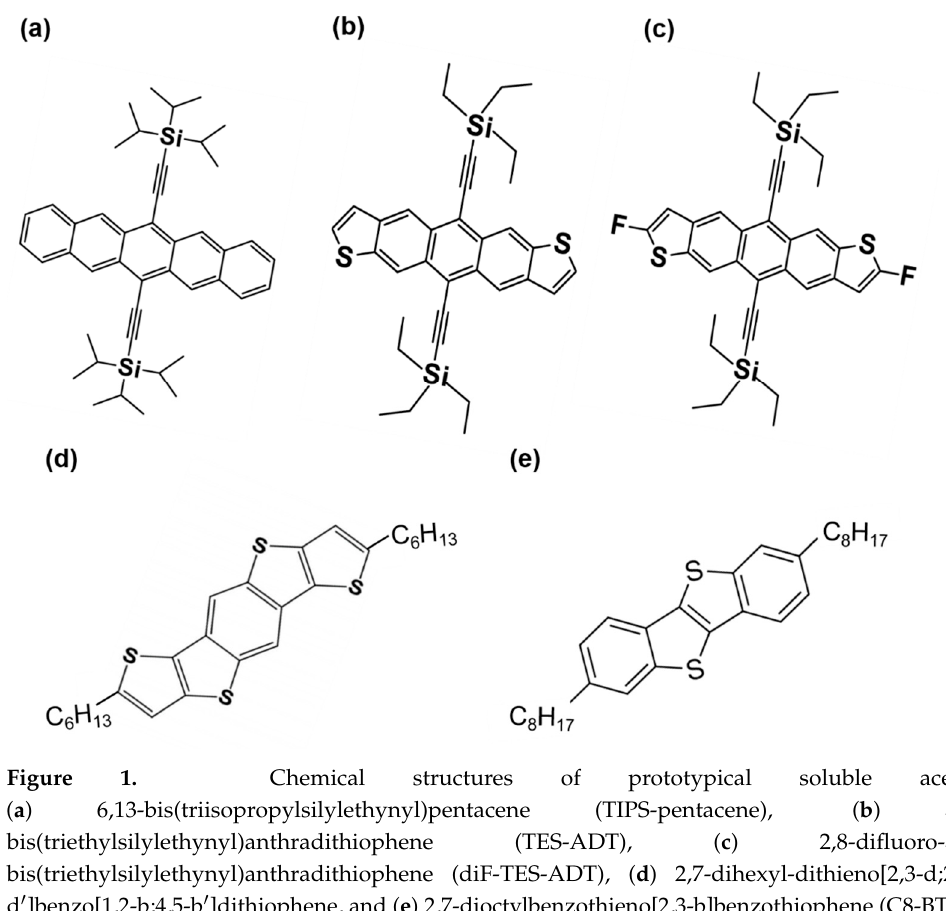
Figure 1. Chemical structures of prototypical soluble acenes: ( a ) 6,13-bis(triisopropylsi- lylethynyl)pentacene (TIPS-pentacene), ( b ) 5,11-bis(triethylsilylethynyl)anthradithiophene (TES- ADT), ( c ) 2,8-difluoro-5,11-bis(triethylsilylethynyl)anthradithiophene (diF-TES-ADT), ( d ) 2,7-di- hexyl-dithieno[2,3-d;2 ′ ,3 ′ -d ′ ]benzo[1,2-b;4,5-b ′ ]dithiophene, and ( e ) 2,7-dioctylbenzothieno[2,3- b]benzothiophene (C8-BTBT). d (cid:48) ]benzo[1,2-b;4,5-b (cid:48) ]dithiophene, and ( e ) 2,7-dioctylbenzothieno[2,3-b]benzothiophene